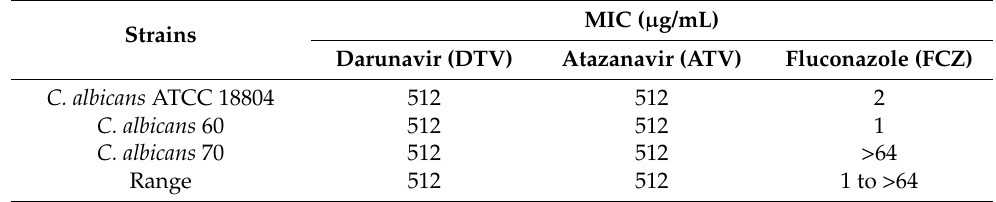
Table 1. Minimal inhibitory concentration values (MIC; µ g/mL) of atazanavir (ATV), darunavir (DRV), and fluconazole (FCZ) against C. albicans strains ATCC 18804, C. albicans 60 and C. albicans